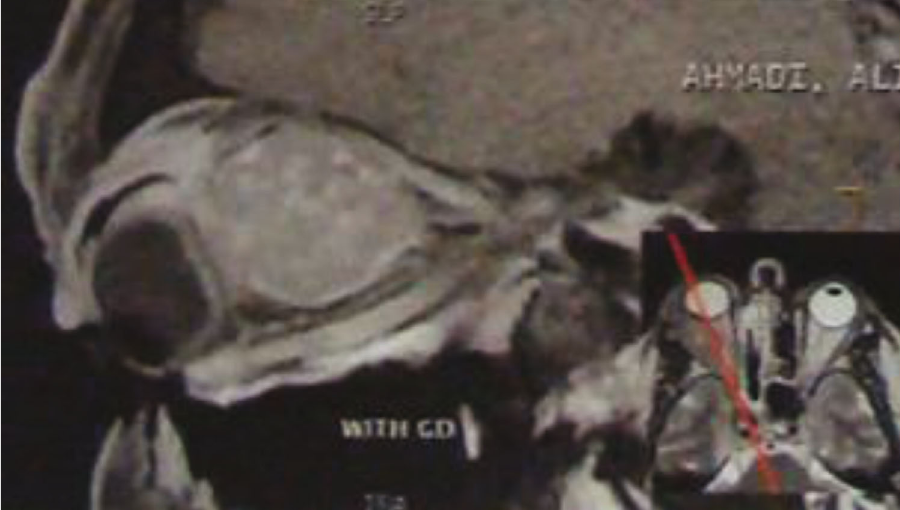
Figure 2: Sagittal MRI scan showing orbital mass with lateral rectus